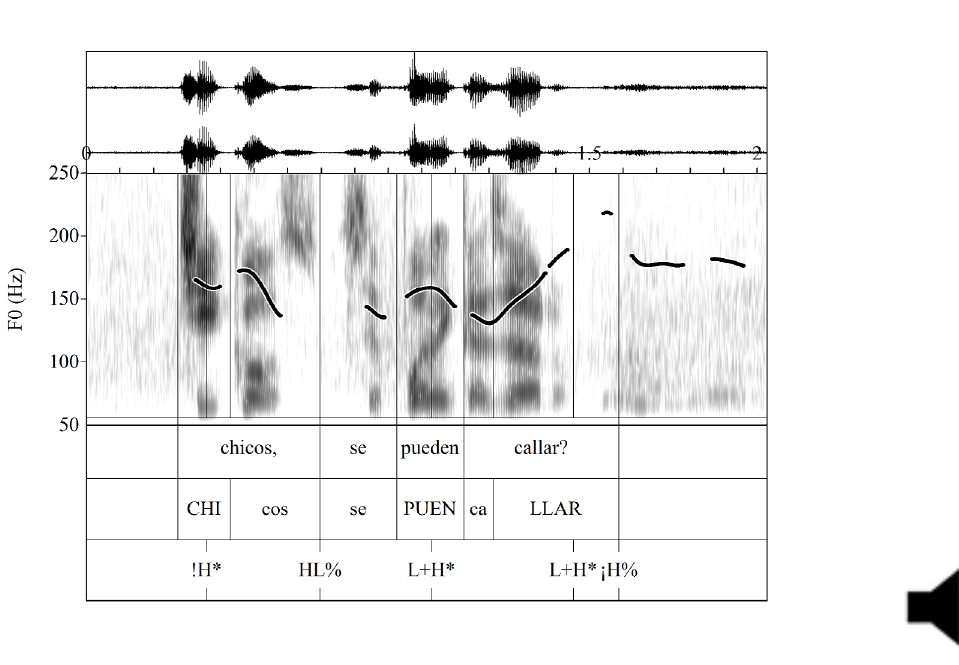
Figure 18 (Participant 5) : Waveform and F0 trace for the imperative yes-no question ¿ Chicos, se pueden callar? ‘Kids, can you please be quiet?’ produced with two IPs. The imperative itself is realized as L+H* (pre-nuclear accent) and as L+H* ¡H% (nuclear